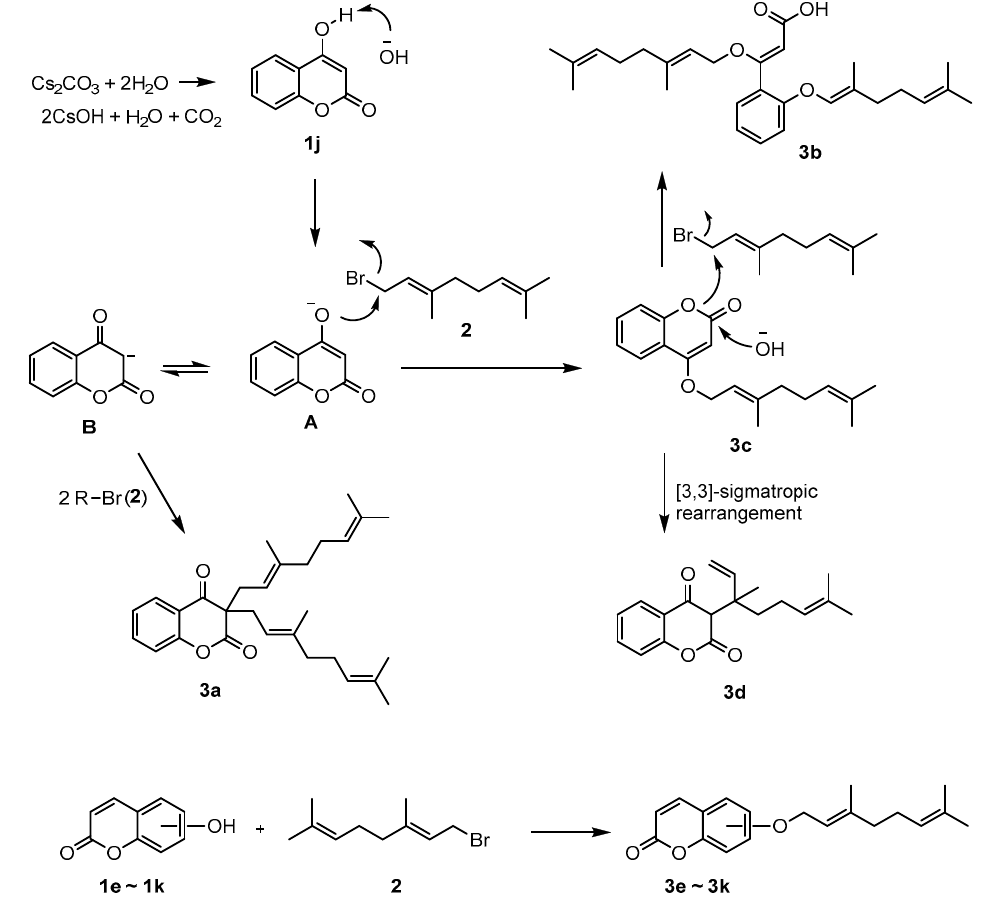
Figure 1. Reaction between hydroxycoumarin and alkenyl halide.